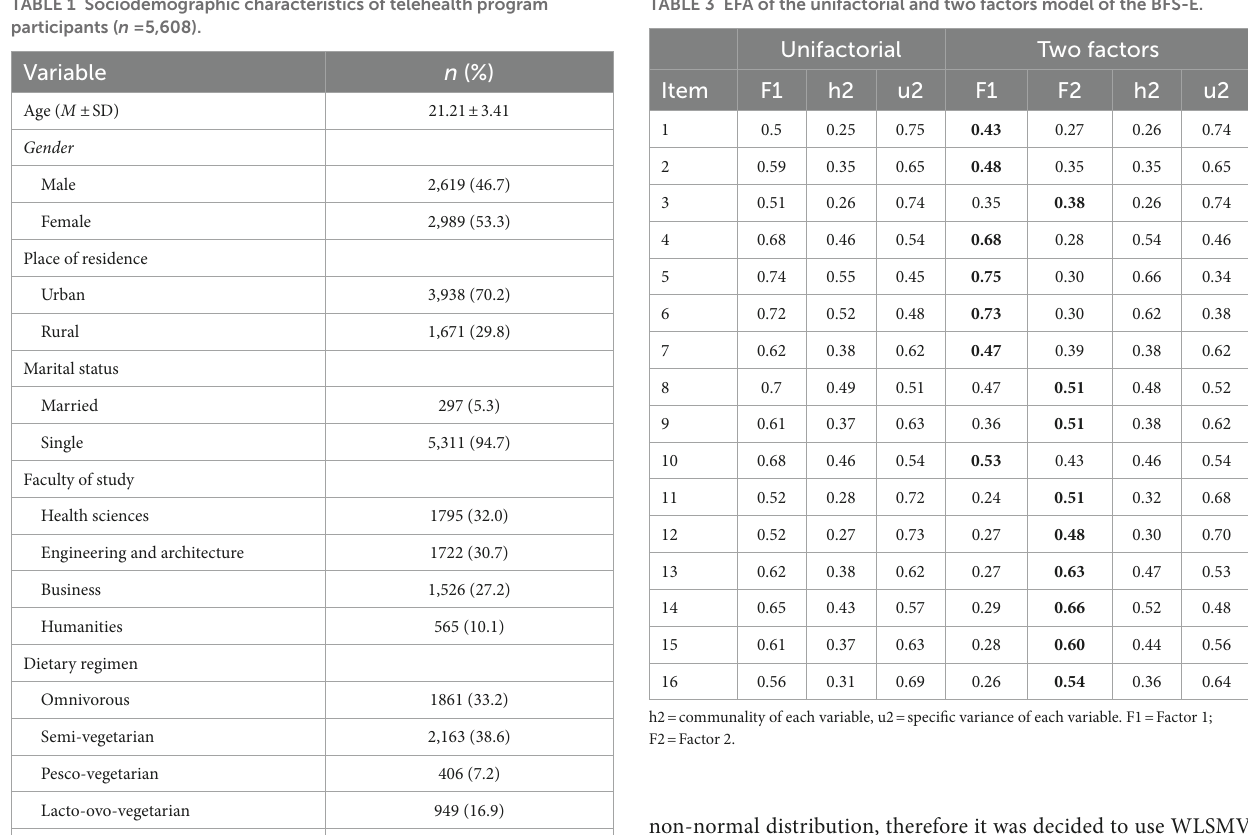
TABLE 3 EFA of the unifactorial and two factors model of the